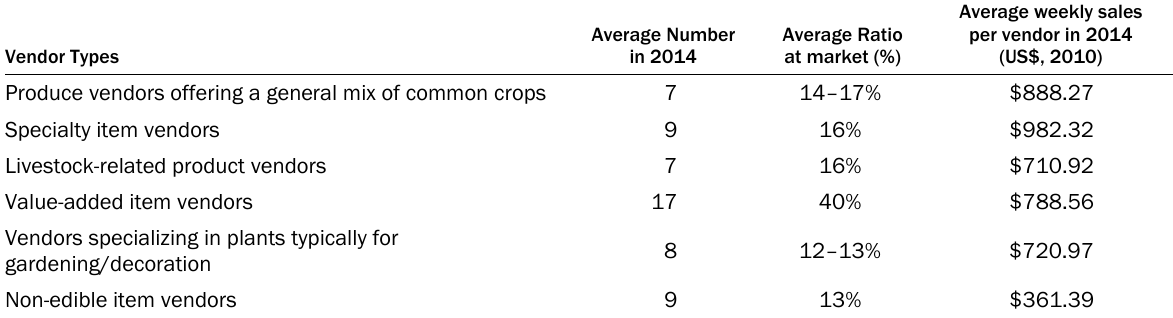
Table 1. Comparisons by Vendor